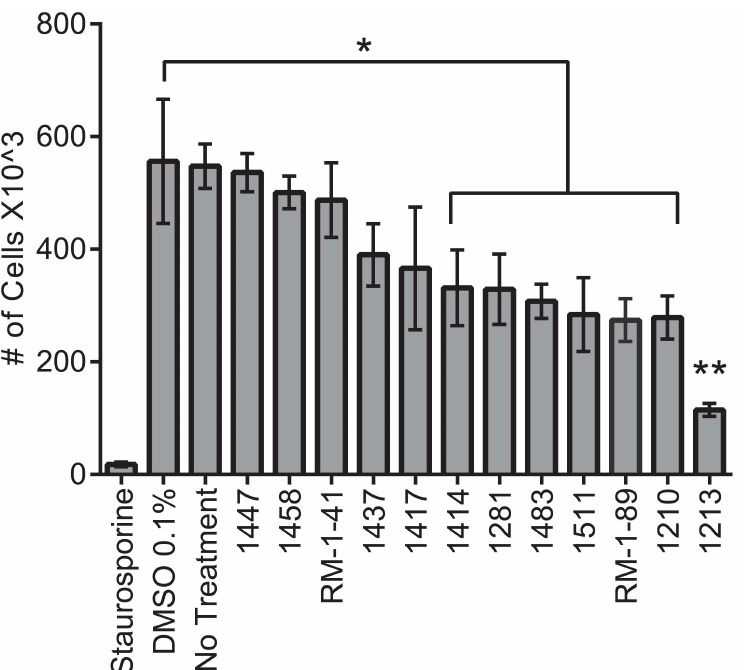
Fig 3. Bumped kinase inhibitors impact Giardia trophozoite growth. A subset ~10% of the existing BKI library was screened for impairment of Giardia growth at a concentration of 5 μ M and results from selected compounds are shown. The generalkinase inhibitor staurosporine reduced growth by 95%. Five bumped kinase inhibitorsreduced growth by at least 50% (1483, 1511, Rm-1-89, 1210 and 1213.) The results are averaged from 3 biologicalreplicatesthat were normalizedto the control, DMSO 0.1%. Significance was evaluatedby t-test, * = p < 0.05, ** = p <